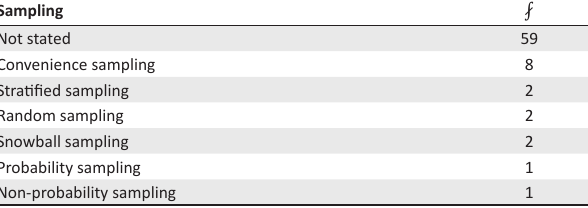
TABLE 4: Sampling method use